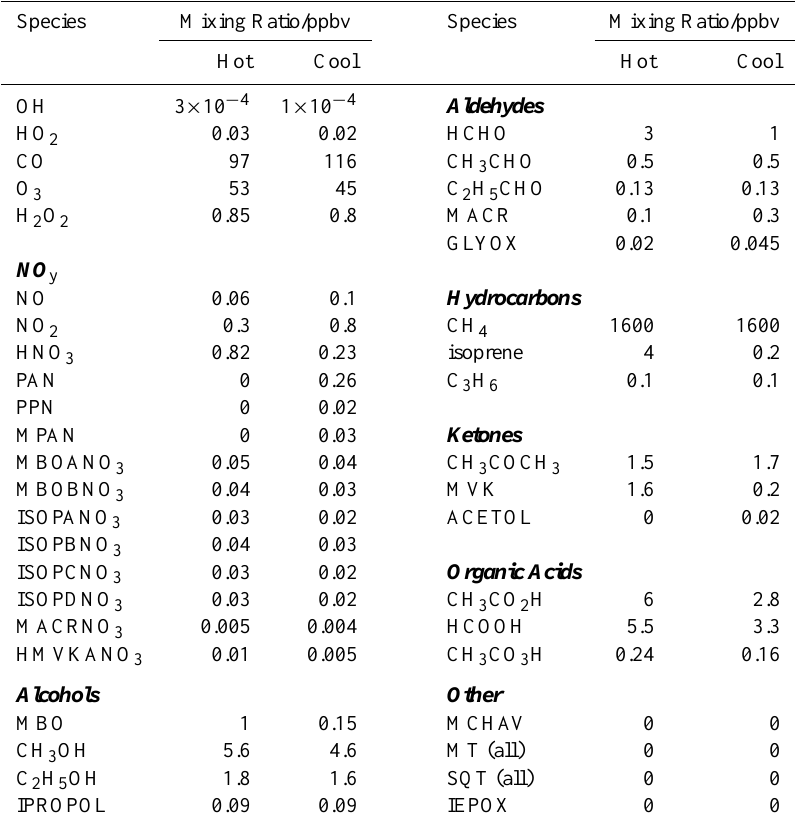
Table 4. Initial/advection concentrations inppbv. Species not listed have initial/advection concentrations set to 0. Species Mixing Ratio/ppbv